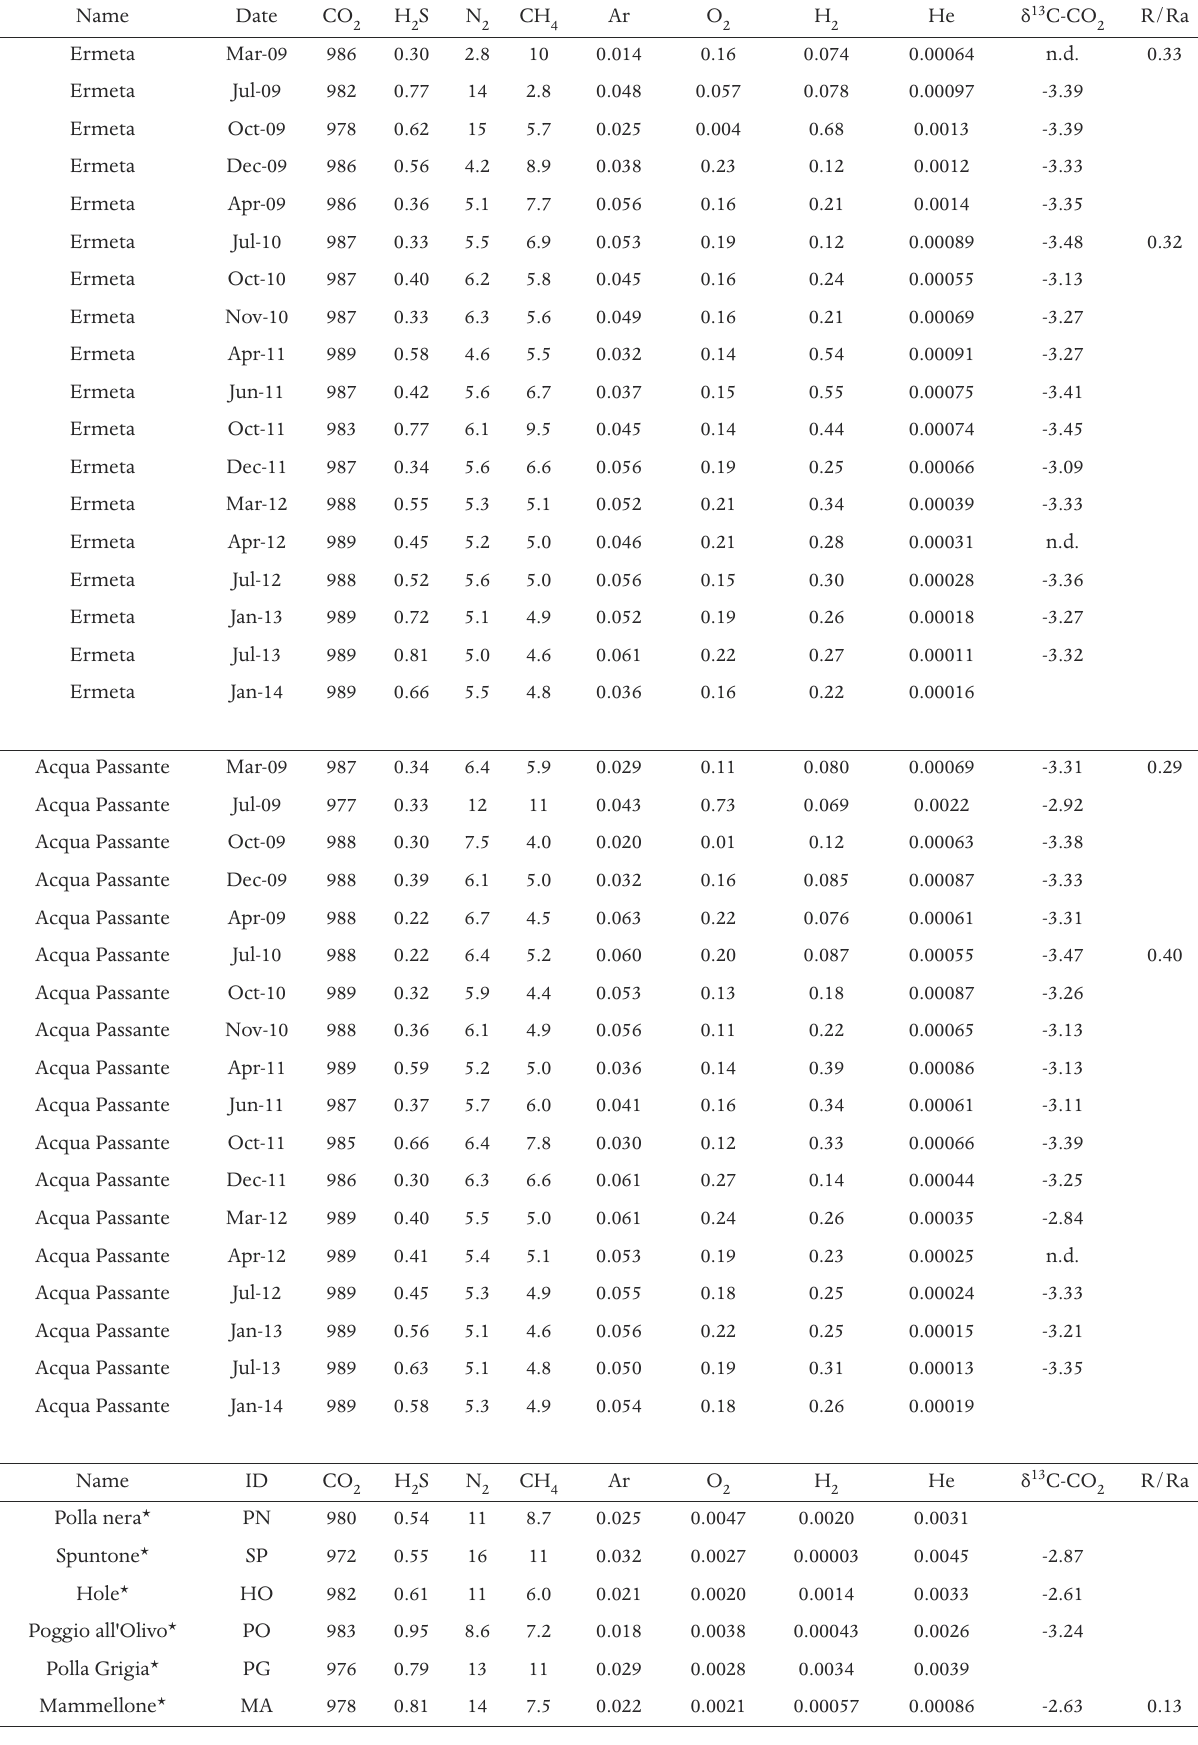
vs. V-PDB ‰; and helium as R/Ra) composition of the Ermeta and 2